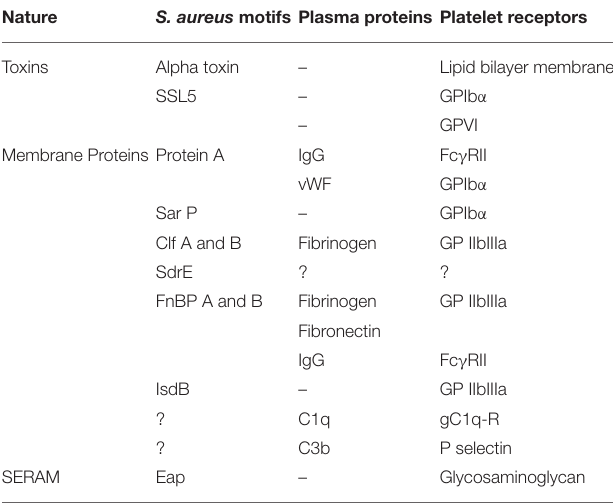
Summary table of the main ligand receptor pairs on both sides of the platelets and S. aureus, requiring or not intermediate plasma proteins. SERAM, secreted expanded repertoire adhesive molecules; SSL5, staphylococcal superantigen-like 5; Sar P, staphylococcal accessory regulator protein; Clf, clumping factor; Sdr E, serine- aspartate repeat protein E; FnBP, fibronectin binding protein; Isd B, iron-responsive surface determinant B; Eap, extracellular adherence protein. vWF, Von Willebrand Factor;?, unknown